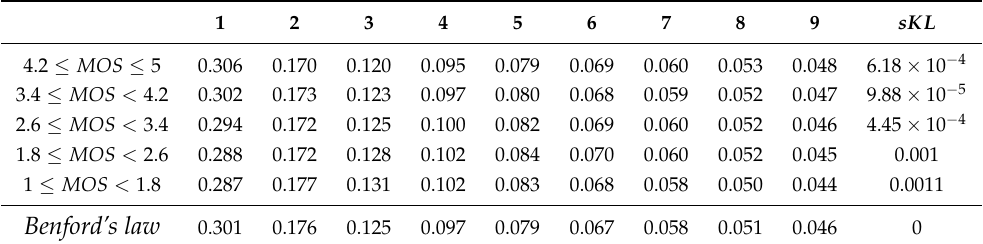
Table 5. Mean FDD of 3D DFT coefficients in KoNViD-1k [22] with respect to different MOS intervals. In KoNViD-1k [22], the lowest possible video quality is represented by MOS = 1.0, while MOS = 5.0 stands for the highest possible video quality. In the last column, the symmetric Kullback–Leibler ( sKL ) divergences between the actual FDD and the Benford law distribution are given.